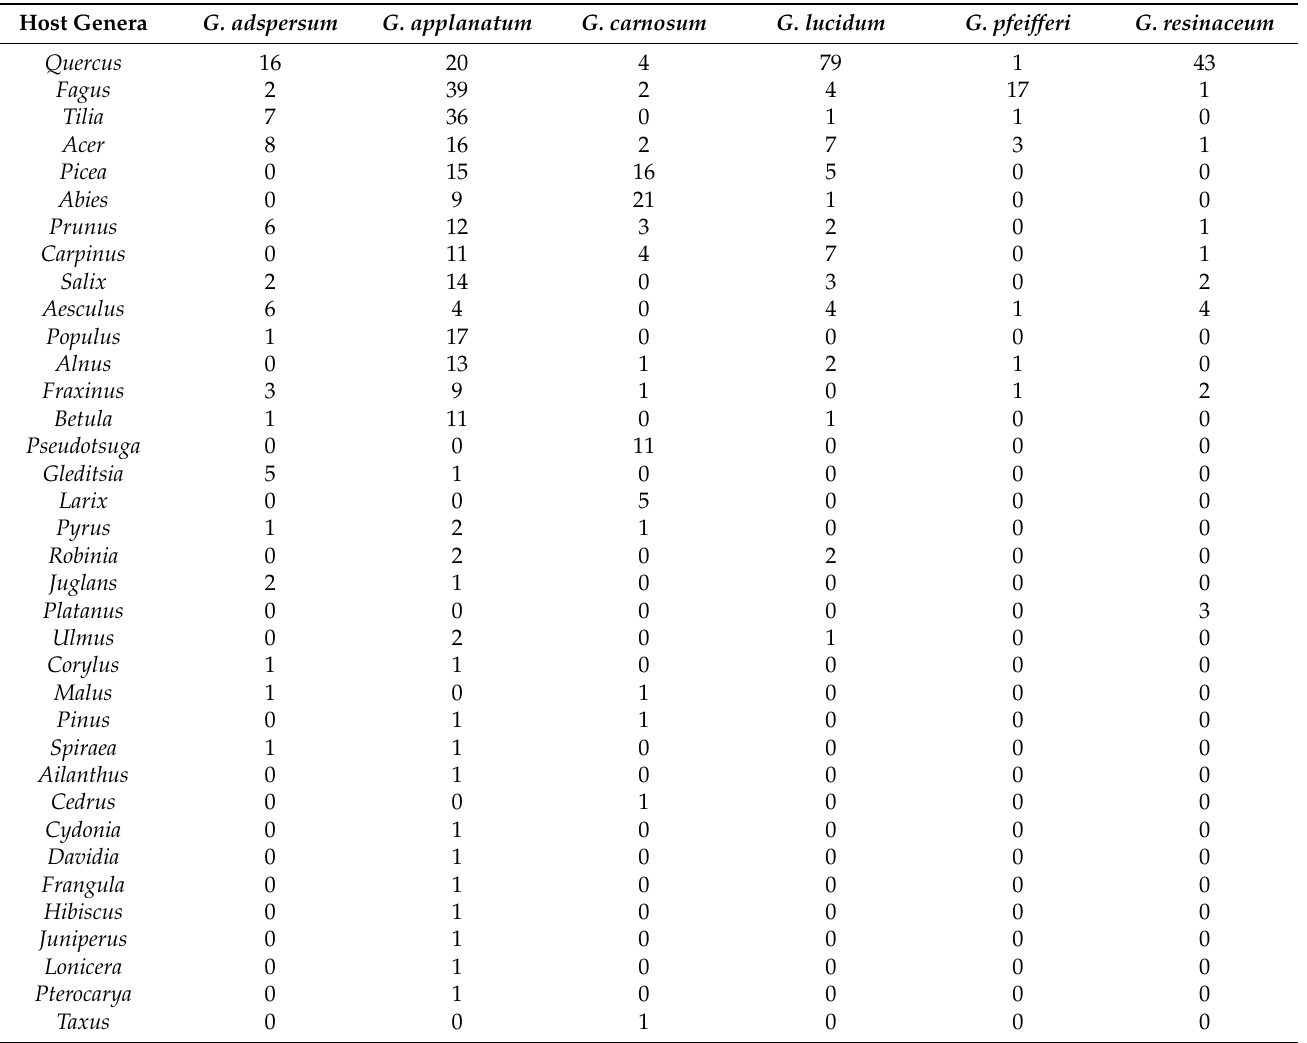
Figure 5. Genera accumulation curves showing the level of host specificity of individual Ganoderma species. The axes shortened for clarity. Table 2. Number of records for individual Ganoderma species associated with different host genera (ranked by appearance). Host